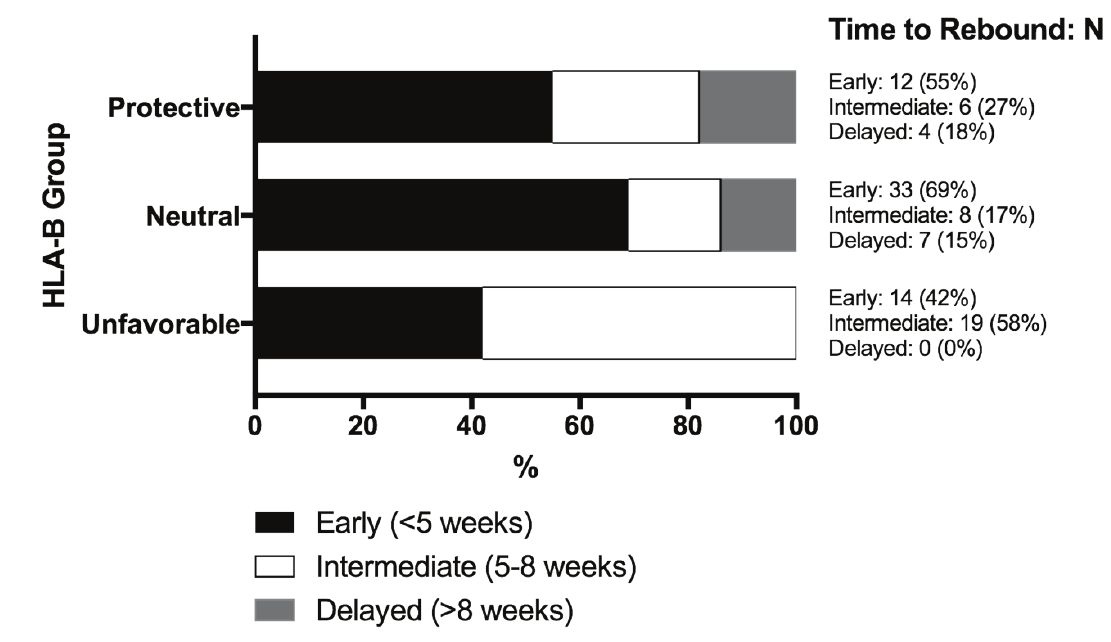
Supplementary Figure 1. Univariate analysis of associations at HLA-B locus. Proportions of partici- pants in HLA-B groups grouped based on their time to viral rebound to ≥ 200 HIV RNA copies/mL.